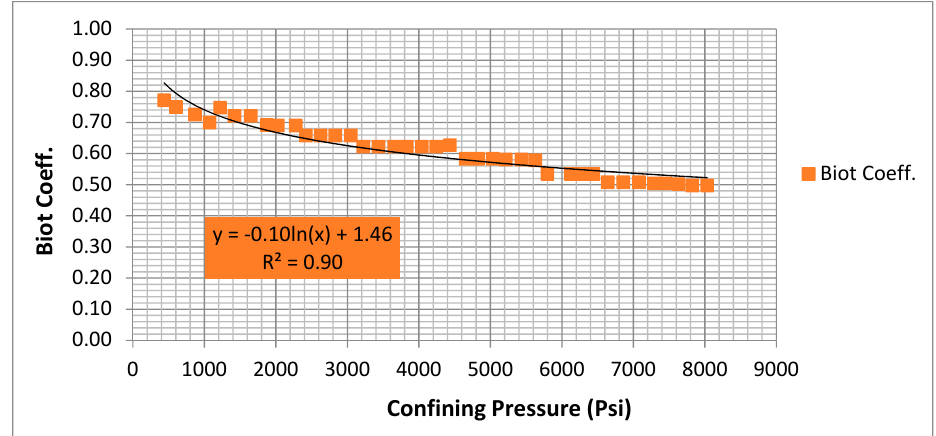
Figure 11. Biot coefficient vs. confining pressure for C5.